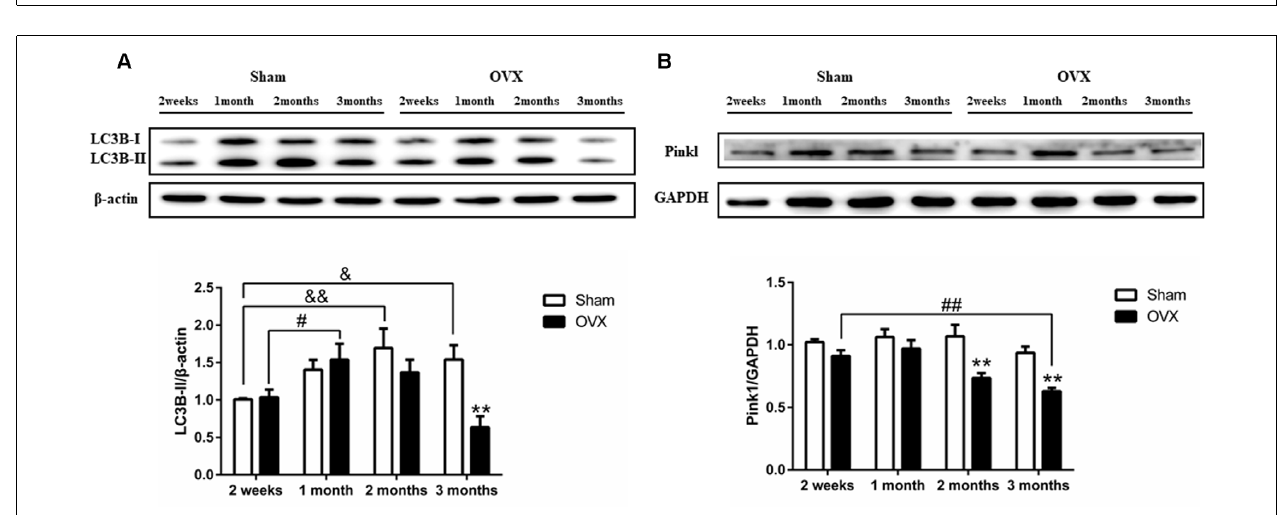
FIGURE 6 | Levels of the mitochondrial dynamics proteins (A) OPA1, (B) Mfn2 (B) , and (C) phosphorylated Drp1 (p-Drp1) in the hippocampus of mice after sham surgery (Sham) or ovariectomy (OVX). Bars represent mean values ± standard error of the mean (SEM). ∗ p < 0.05, ∗∗ p < 0.01, ∗∗∗ p < 0.001 compared with the Sham mice at the same timepoint; # p < 0.05, ## p < 0.01 compared with the 2-week OVX group ( n = 4).